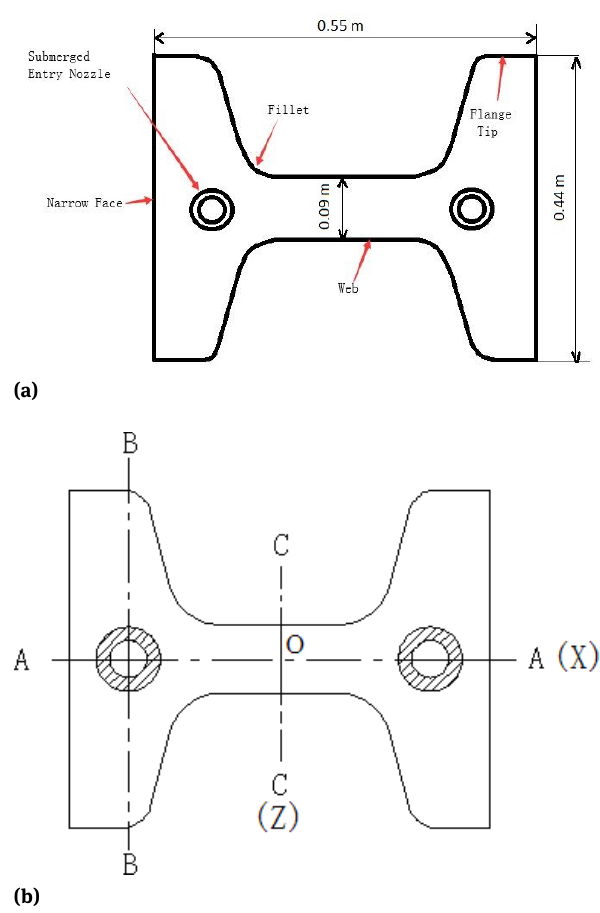
Figure 8: Cross-section of beam blank and submerged entry